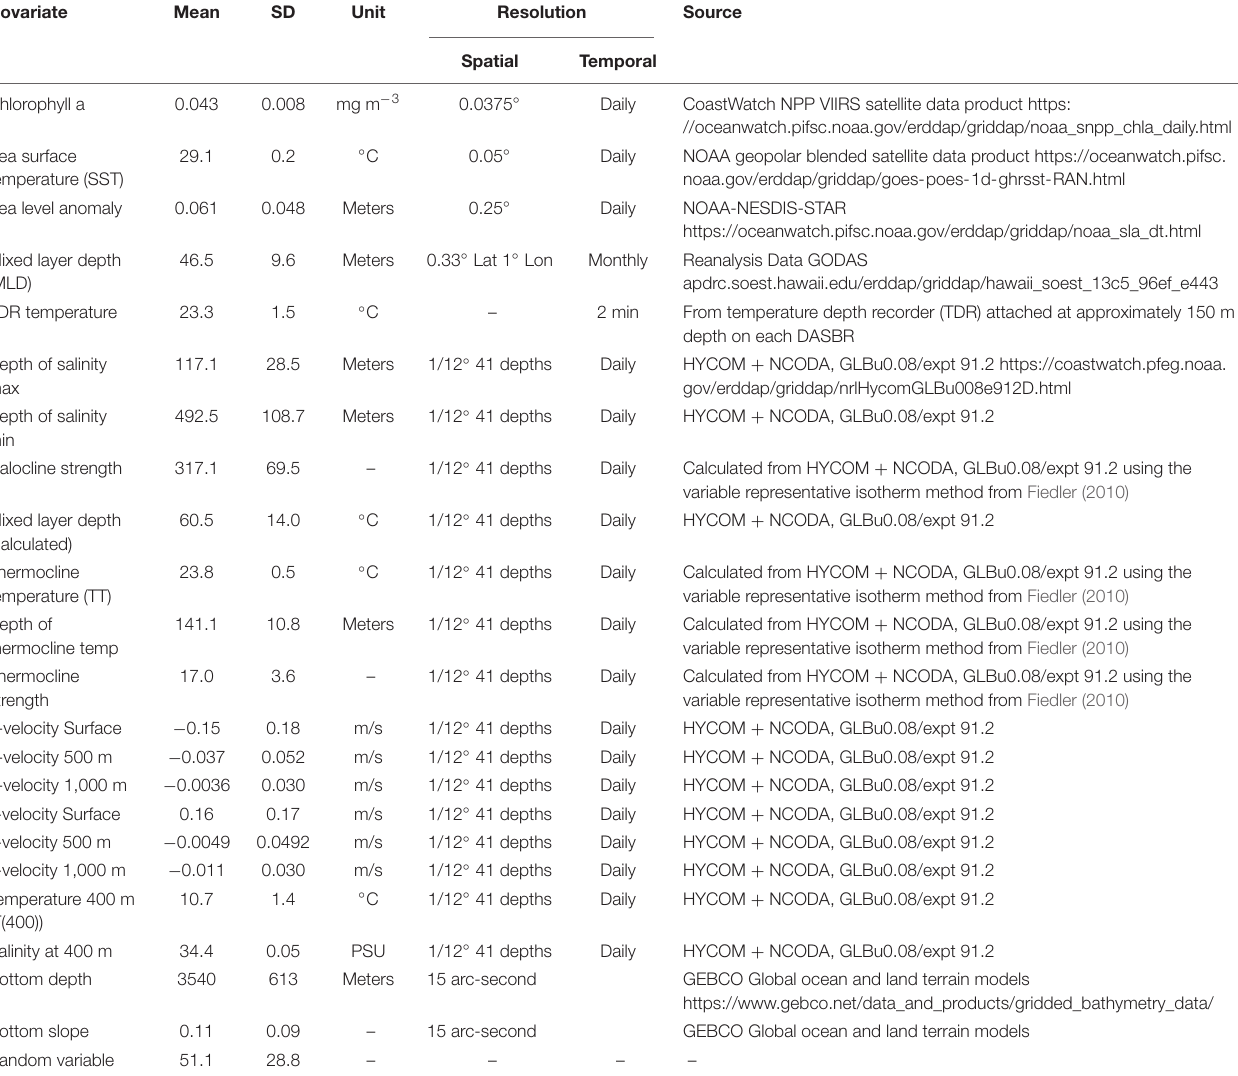
TABLE 2 | Environmental covariates used as predictors for the generalized additive mixed models.